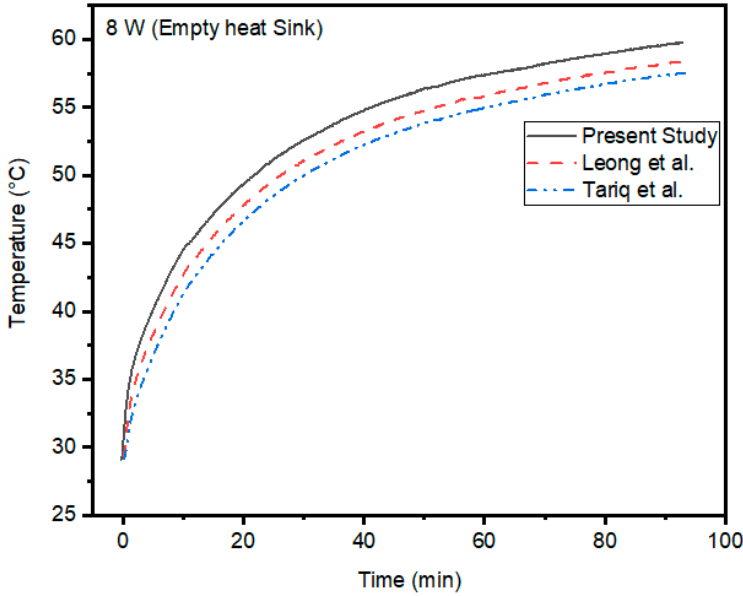
Figure 12. Validation of present experimental setup with the previous studies